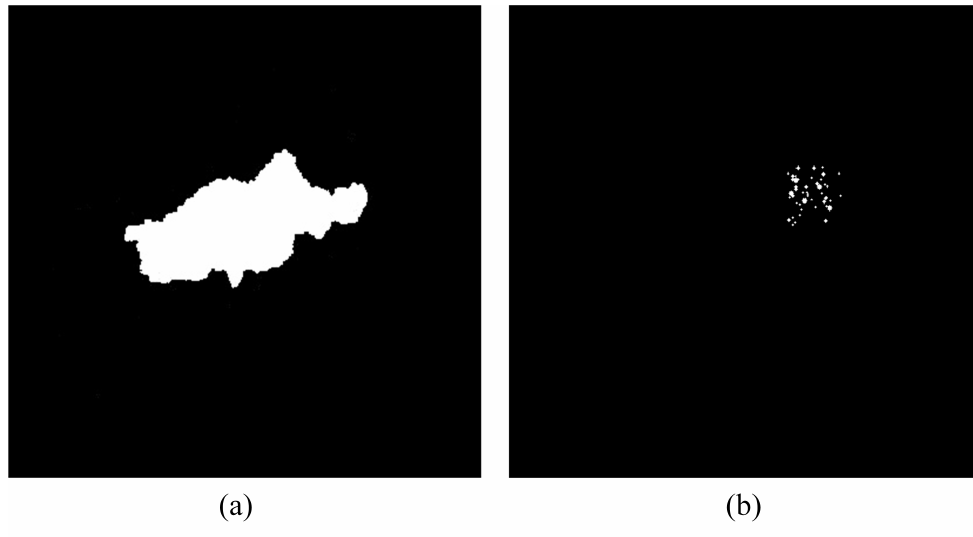
Figure 7. Ground truth of the image pair with small lesions and big lesions. ( a ) Big lesions; and ( b ) small